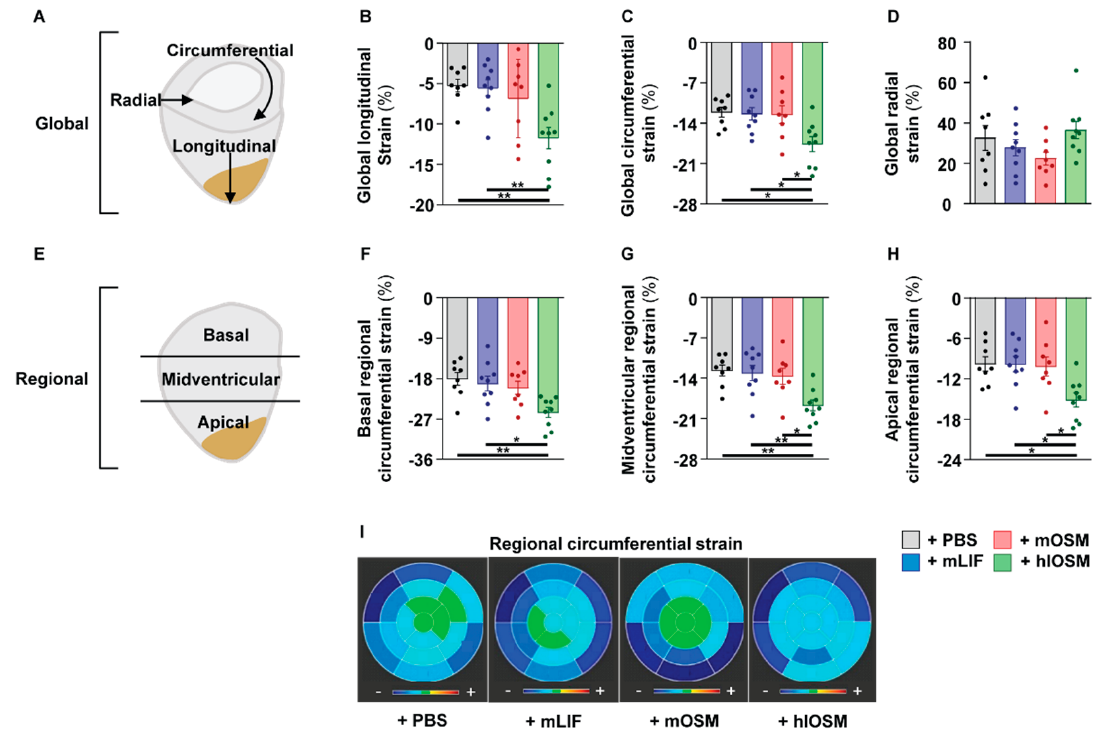
Figure 6 . Simultaneous activation of the OSMR and LIFR by hlOSM preserves cardiac architecture and contractility after the onset of myocardial infarction. ( A ) Schematic illustration of the different global myocardial strain directions of the left ventricle: longitudinal shortening, circumferential shortening and radial thickening. Statistical analysis of magnetic resonance imaging-based ( B ) global longitudinal strain, ( C ) global circumferential strain and ( D ) global radial strain of the left ventricle at Day 28 post-MI following systemic injections of 100 ng recombinant mLIF, mOSM and hlOSM per gram of body weight at Days 0, 1, 2 and 3. Injections of equivalent volumes of sterile PBS, i.e., 100 µL per mouse, served as controls (+ PBS, n = 8; +mLIF, n = 9, +mOSM, n = 8 and +hlOSM, n = 9). ( E ) Schematic illustration of the subdivision of the left ventricle into basal, midventricular, and apical segments used for regional circumferential strain (RCS) analyses. Statistical analysis of ( F ) basal RCS, ( G ) midventricular RCS and ( H ) apical RCS. Statistical analysis was performed by one-way ANOVA. Asterisks indicate Bonferroni post-hoc test significances between cytokine- and PBS–treated mice with * p < 0.05 and ** p < 0.01. Data are presented as mean ± sem. ( I ) Representative bull’s-eye plots illustrating the distribution of left ventricular regional circumferential strain values in PBS–, mLIF–, mOSM– and hlOSM–treated mice. The outer circle corresponds to basal, the middle circle to midventricular, and the inner circle to apical areas. Blue colors display negative strain values. Green colored areas reflect positive strain values.